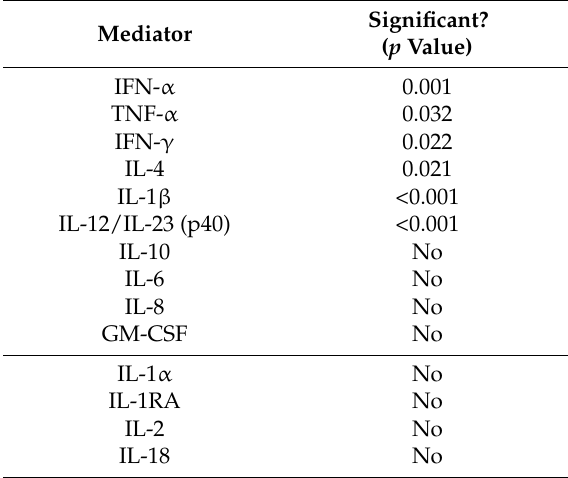
Table 2. Traditional Statistical Analyses of MP vs. CSP Inflammatory Data